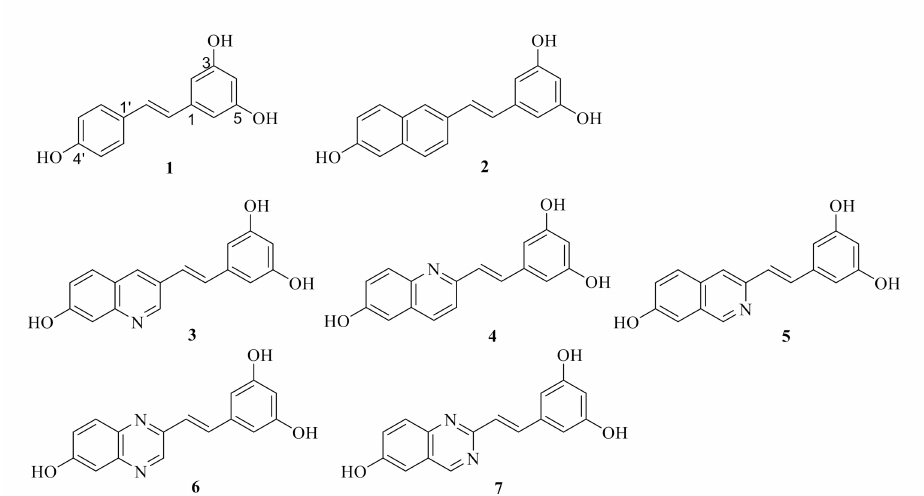
Figure 1. Structures of resveratrol ( 1 ) and its naphthalene ( 2 ), quinoline ( 3 and 4 ), isoquinoline ( 5 ) quinoxaline ( 6 ) and quinazoline ( 7 )